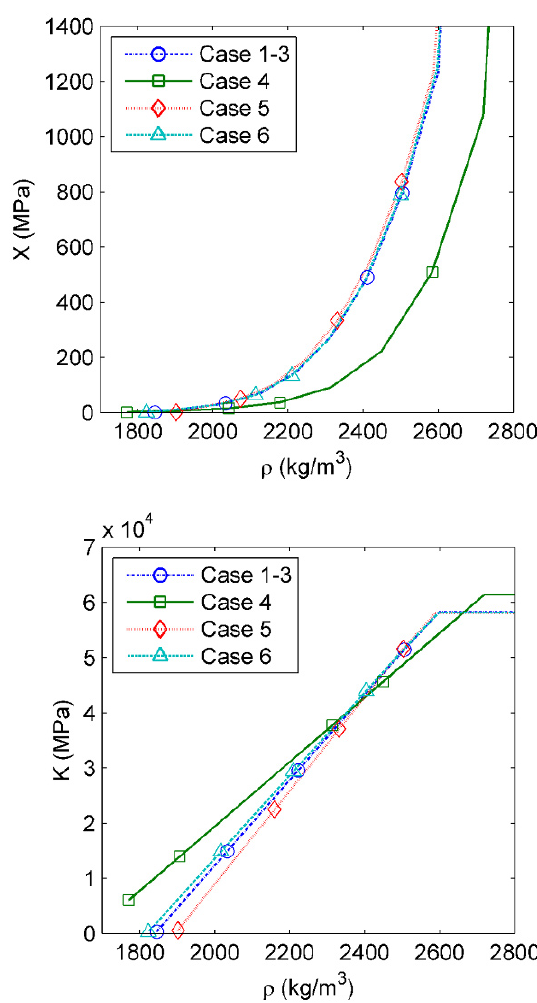
Figure 13. Cap position (X) and bulk modulus (K) as function of density for the different simulation cases.